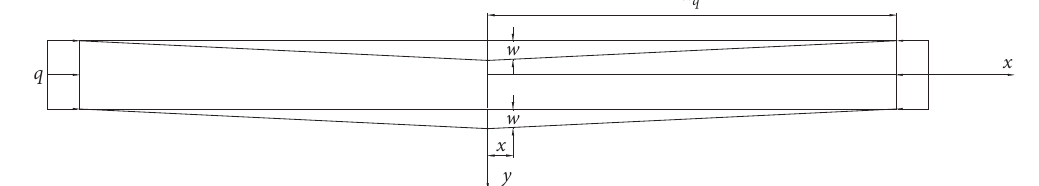
Figure 1: Mechanical model of roof stability considering compressive bar stability.